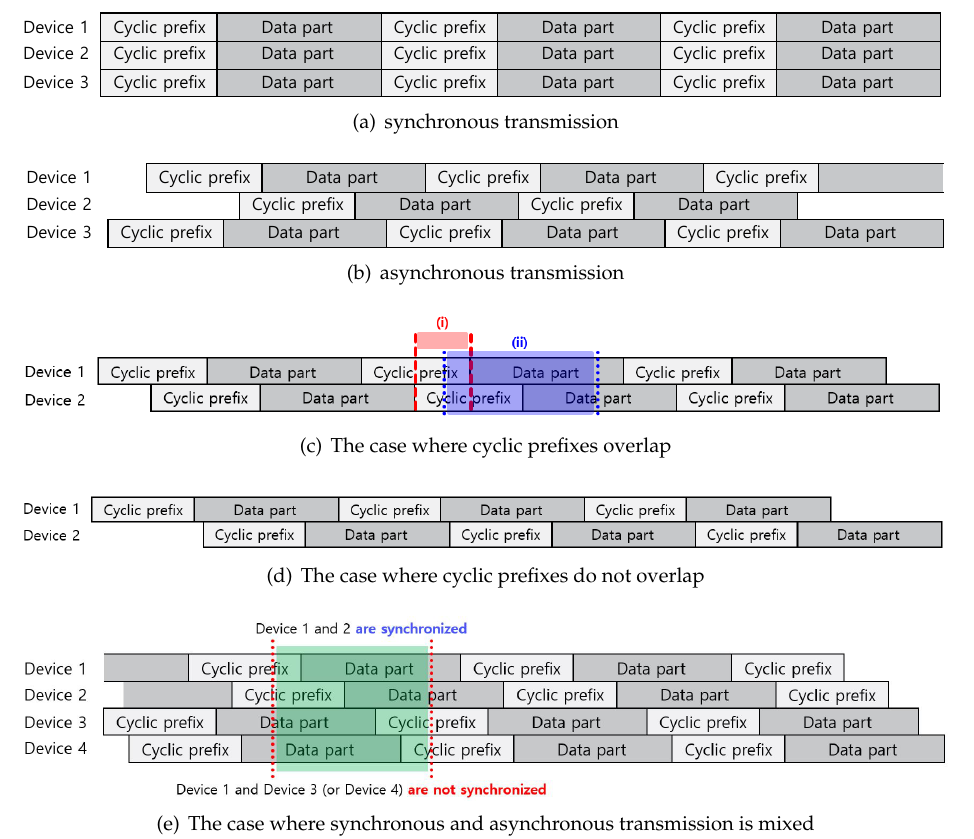
Figure 1. Example of CPs overlapping and not